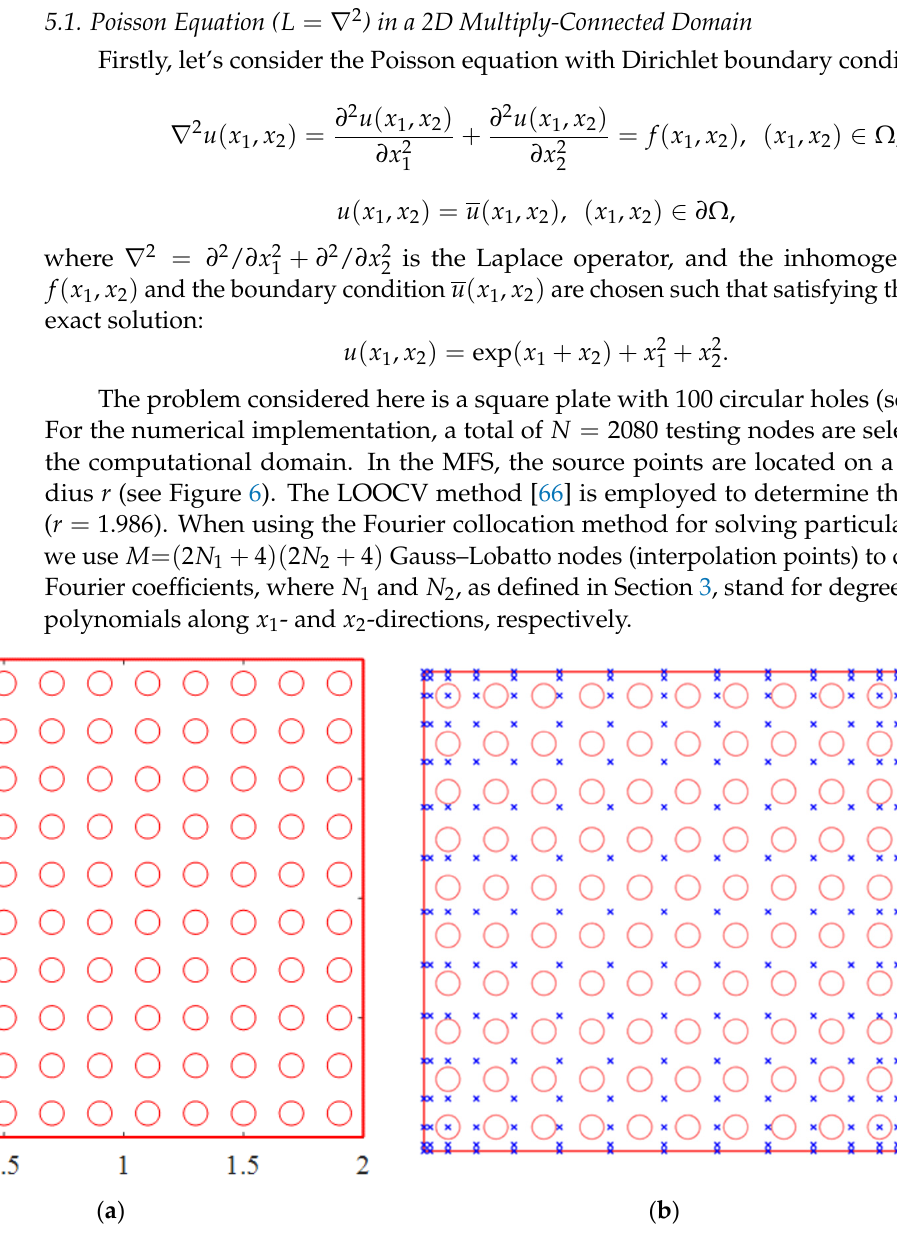
Figure 5. Geometry of the problem ( a ) and the distribution of the shifted Gauss–Lobatto nodes ( b ). Firstly, we study the convergence of the present method with the degree of Fourier polynomials. For this, Table 2 shows the maximum and global errors of the calculated temperatures using the present FCM-MFS approach, as the degrees of Fourier polynomials increase from N 1 = N 2 = 2 to N 1 = N 2 = 14. We can observe that the calculated results are accurate and rapidly convergent as the degree of Fourier polynomials increases. We can also observe that the present method can be quite accurate even with a small degree of Fourier polynomials. The CPU times taken by the proposed method are also given in Table 2. Figure 7a,b shows the contours of errors calculated at points inside the whole domain, by using N 1 = N 2 = 3 and N 1 = N 2 = 8, respectively. The purpose of testing this simple problem is to verify the reliability of the proposed method for the solution of 2D inhomogeneous elliptic